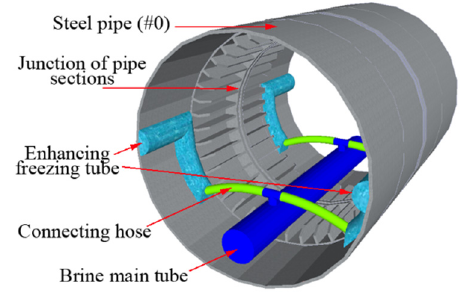
Figure 9 . Freezing tube layout of hollow pipe (#0).